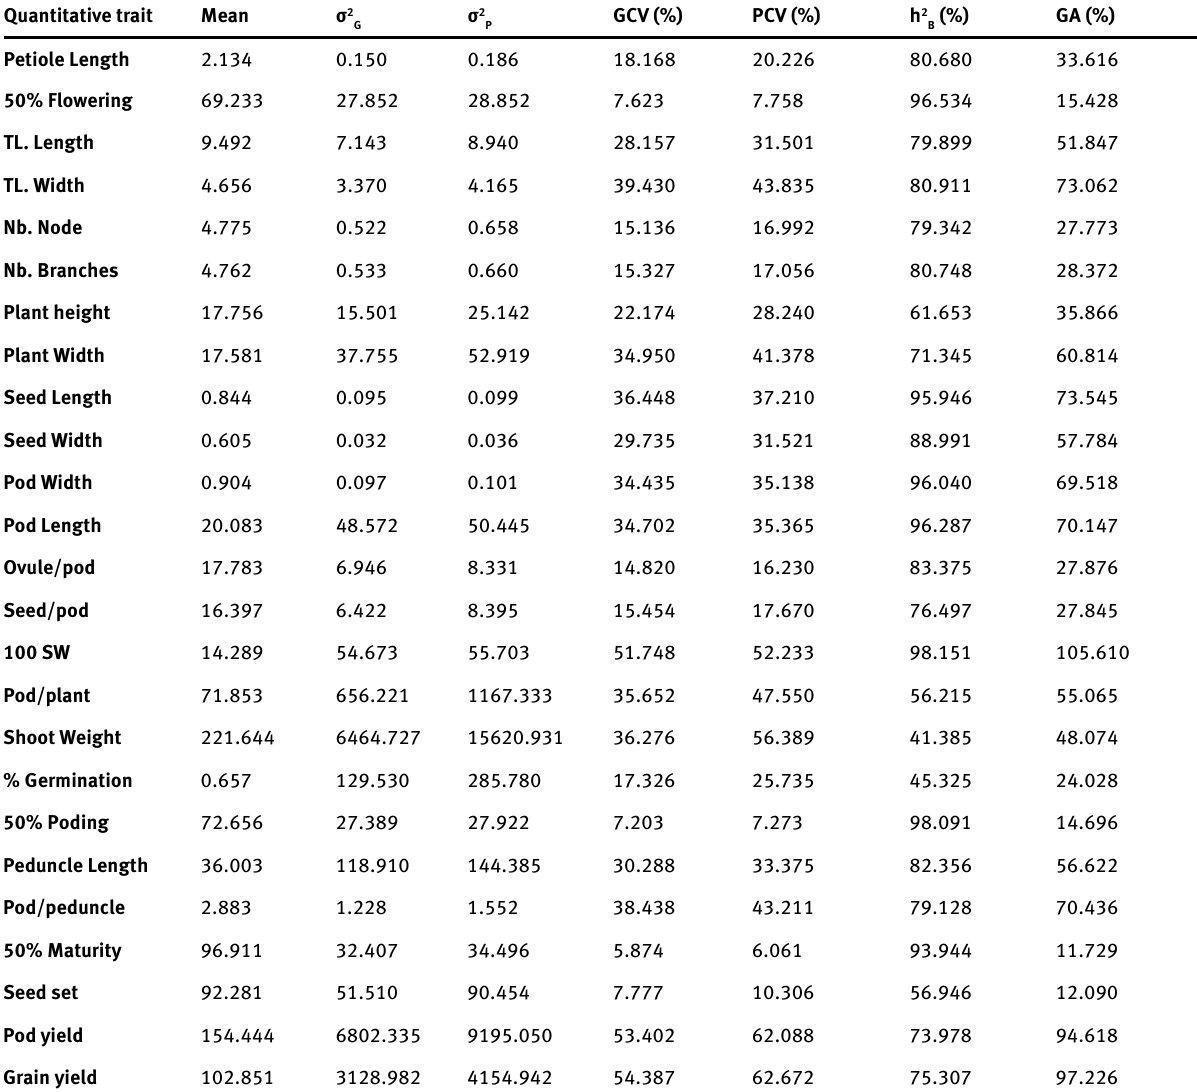
Table 5: Estimates of genotypic and phenotypic variance components, broad sense heritability and Genetic Advance for 25 quantitative traits in cultivated Vigna unguiculata Quantitative